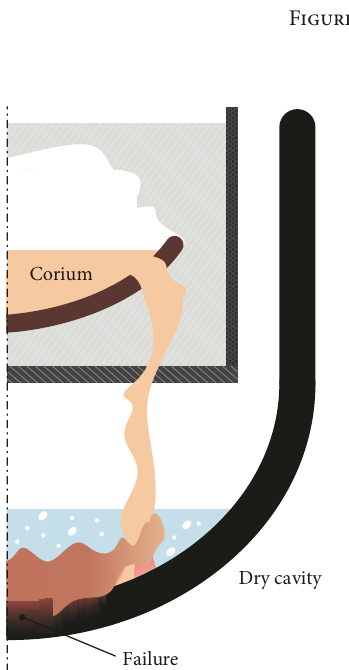
Figure 10: The hot focus during the